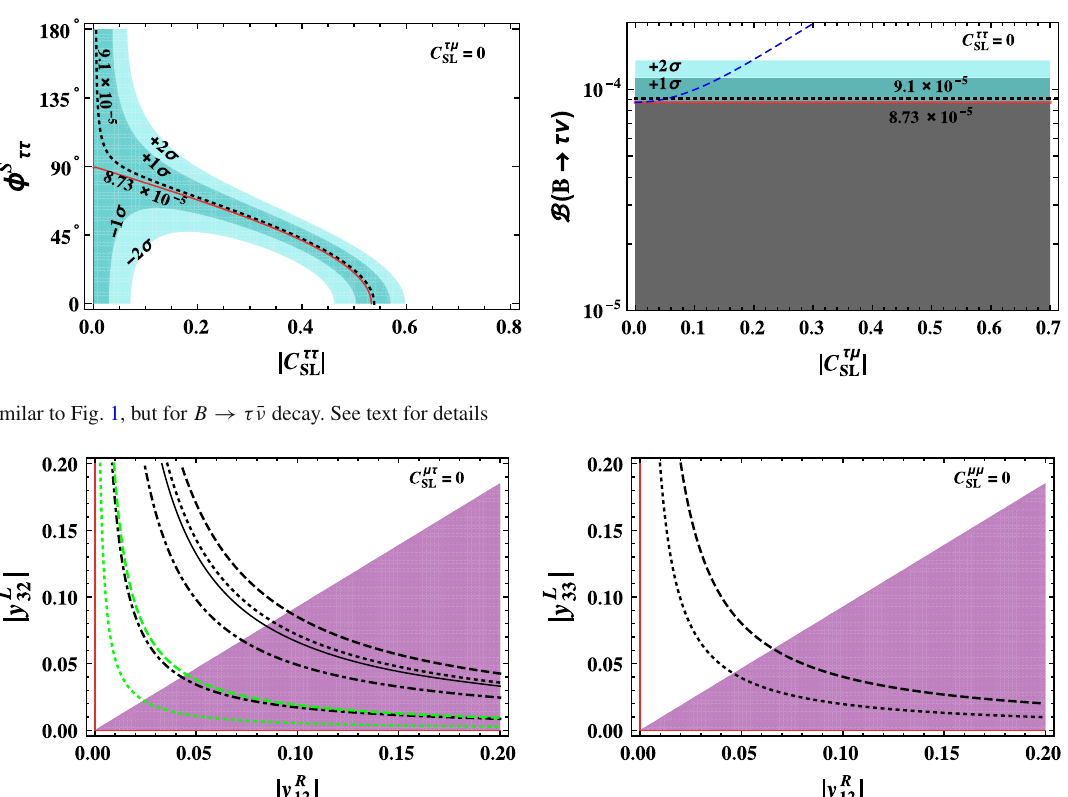
| vs | y L | (left) and | y R | vs | y L | (right) Fig. 3 B ( B → μ ¯ ν) in | y R that these contours do not depend on the overall phase, and hence black 12 32 12 33 = 1 . 2 TeV. The solid contours in both pan- colors does not correspond to any phase labeling. The red solid lines planes, where we take m S 1 in the respective panels illustrate SM expected value when the magni- els represent the SM expectations, whereas the dotted, dotdashed and tude of the any one of the couplings is zero. The purple shaded regions dashed contours denote the central value, − 2 σ and + 2 σ limits of Belle are excluded by ATLAS SLQ pair production [16]. See text for further measurement. In the left panel, the black and green colored contours discussion are for φ μμ = 0 and π respectively. In the right panel the dotted and dashed contours are plotted in black, however, it should be understood